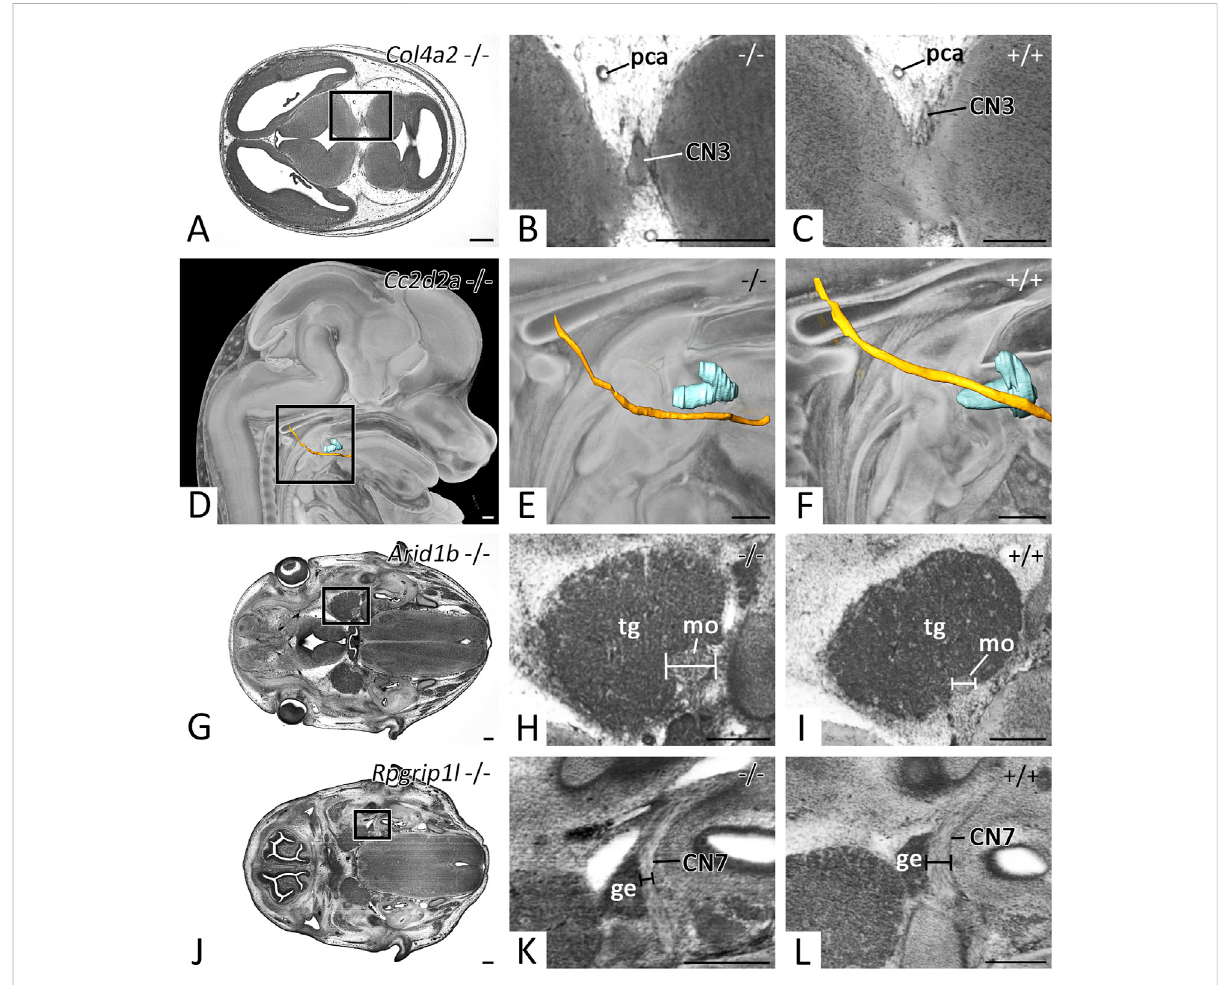
FIGURE 7 Cranial nerve abnormalities in homozygous offspring of embryonically or perinatally lethal KO-lines. Axial HREM sections. Anterior to the left, right on top (A – C, G – L) . Surface renderings in the context of a volume rendering. View from right (D – F) (A – C) Abnormal thickening of CN3 in a Col4a2 − / − mutant (A,B) , (C) serves as control (D – F) Abnormal topology of CN12 (yellow) in respect to the hyoid bone (turquoise) in a Cc2d2a − / − mutant (D,E) , (F) servesascontrol (G – I) Abnormalthickeningofthemotoricpart(mo)ofCN5inan Arid1b − / − mutant (G,H) , (I) servesascontrol (J-L) AbnormalthinningofCN7inan Rpgrip1l − / − mutant (J,K,L) servesascontrol.Abr.ge=geniculateganglion,pca=posteriorcerebralartery,tg= trigeminal ganglion. Scale bars = 250